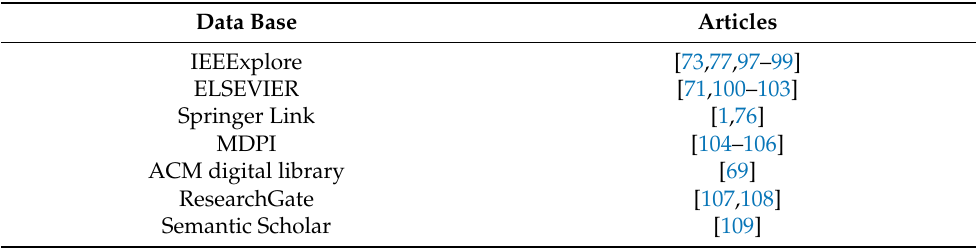
Table 1. Classification of articles by the